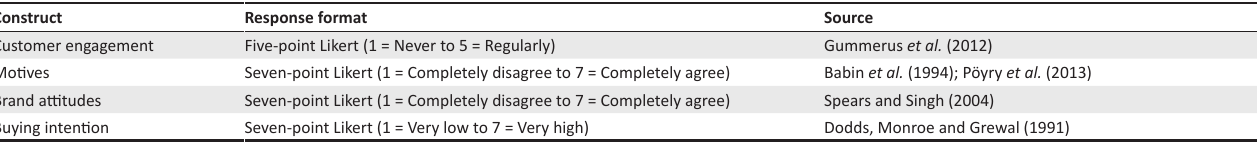
TABLE 1: Measures for constructs.